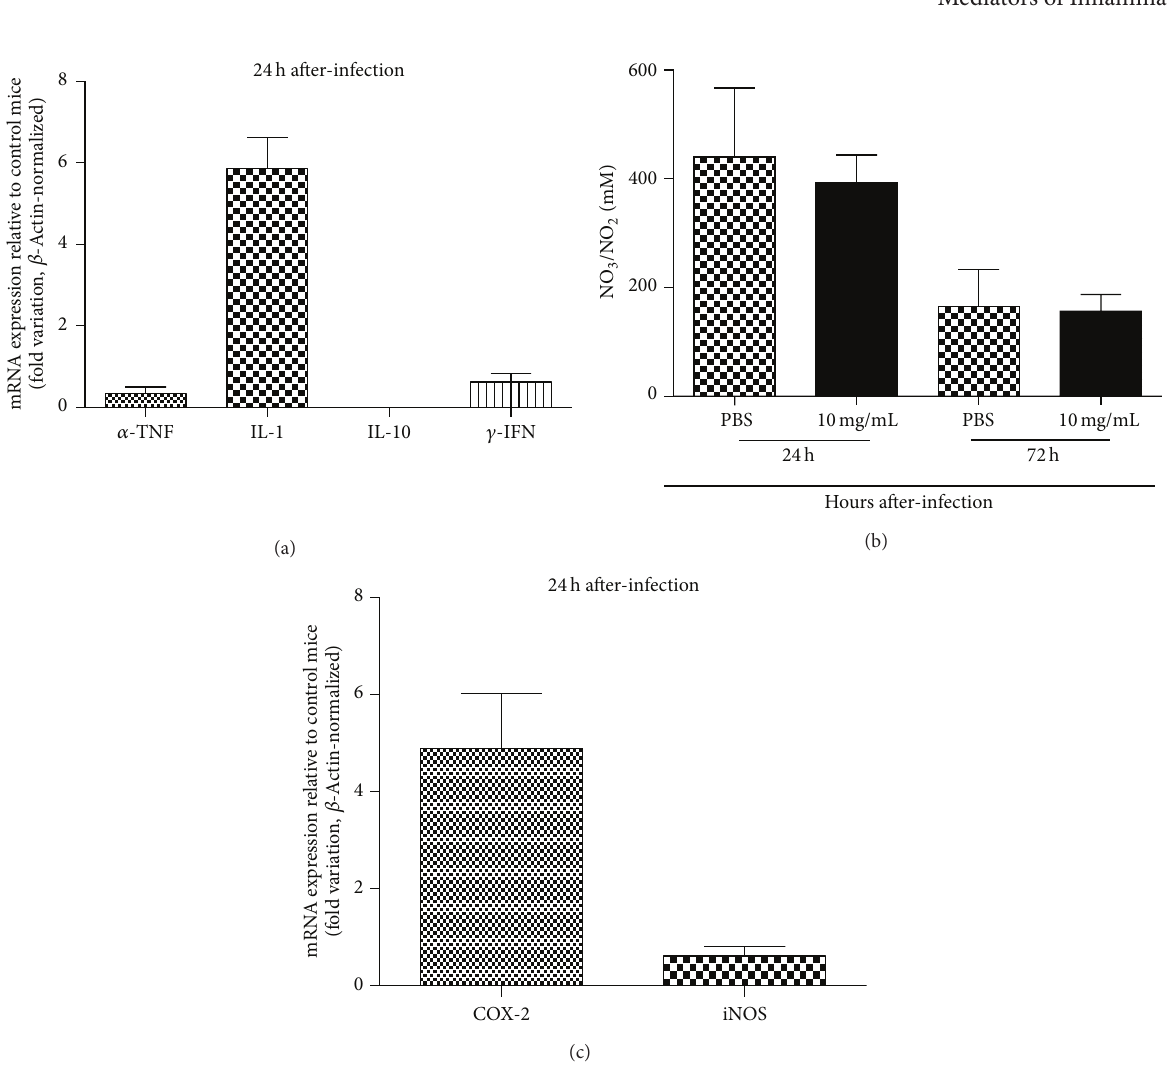
Figure 3: mRNA expression of cytokines and inducible COX-2 and iNOS enzymes besides nitric oxide in serum of P1G10 pretreated mice infected with Salmonella Typhimurium. Comparative real-time PCR results are expressed in fold variation relative to control mice (a and b). Beta-actin was used as internal control. Nitric oxide release in serum was titrated in nitrite form (c). In this case, data comparison was conducted with Student’s 𝑡 -test (b). The confidence interval was determined with 𝑃 < 0.05